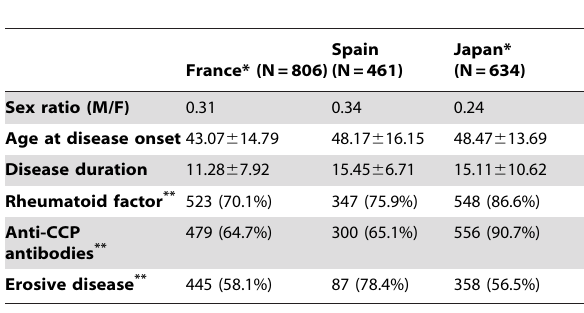
Table 1. Characteristics of rheumatoid arthritis cases investigated for a BLK – BANK1 genetic interaction.